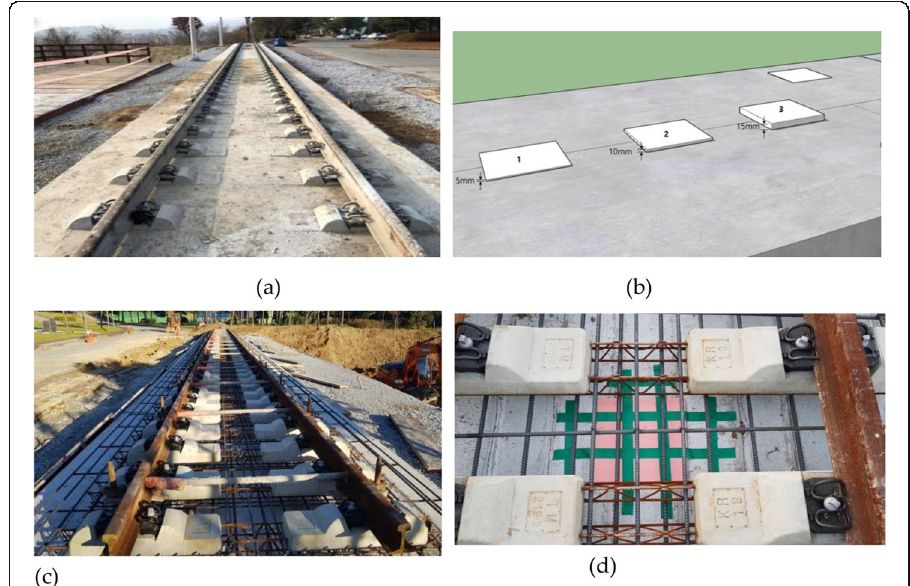
Fig. 6 Track foreground section: a Test section track foreground. b Location of wood blocks. c Foreground before the TCL layer was laid. d Wood block in the